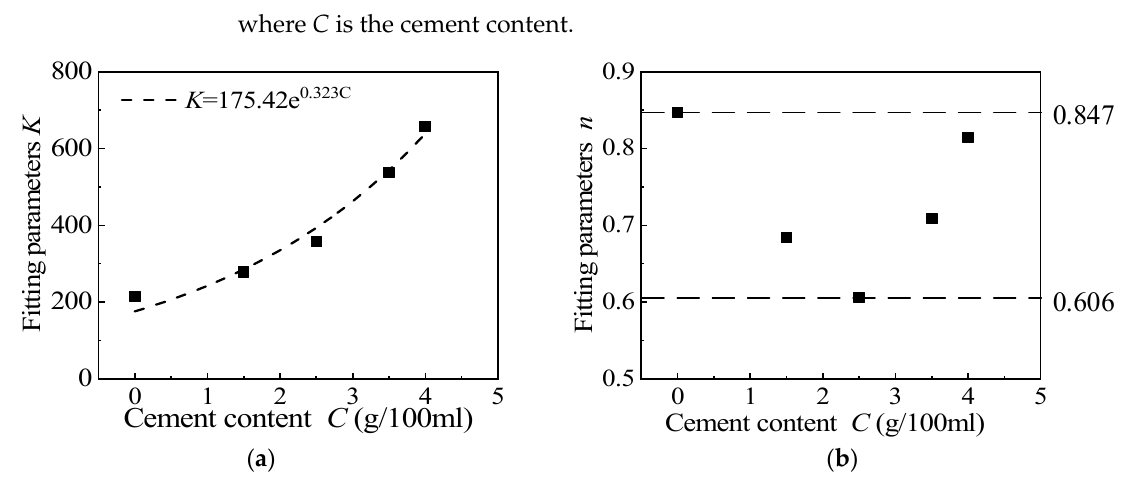
where C is the cement content.